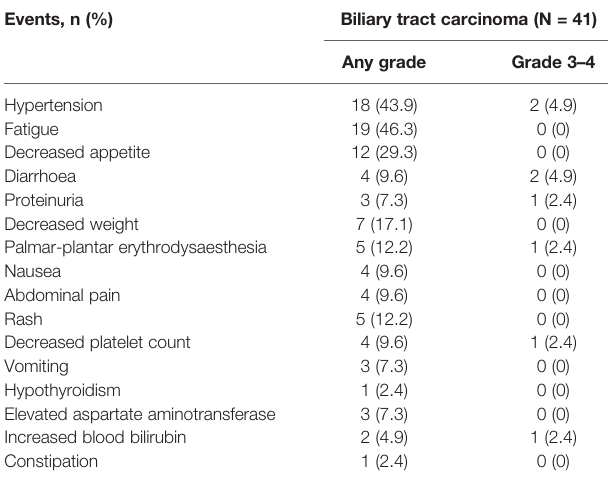
TABLE 3 | Summary of adverse